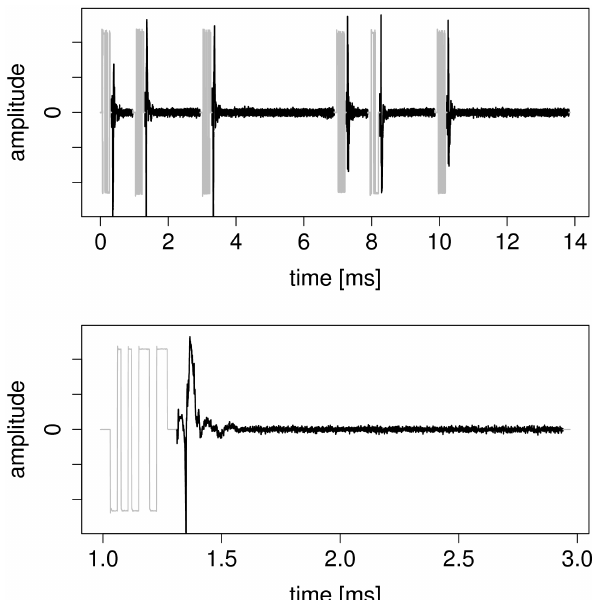
Fig. 3. The real part of raw voltage data from the PPATC experi- ment. The data is from an experiment performed with the EISCAT Tromsø VHF radar on 28 November 2008. Upper panel: Trans- mission signal (grey) and the echoes (black) of two full cycles of the ATC coding. Lower panel: The second transmission pulse of the upper panel and the subsequent echoes. A strong ground clutter signal is seen immediately after the pulse. When analysed with- out clutter suppression, the useful incoherent scatter signal begins around 1.6ms in the plot.